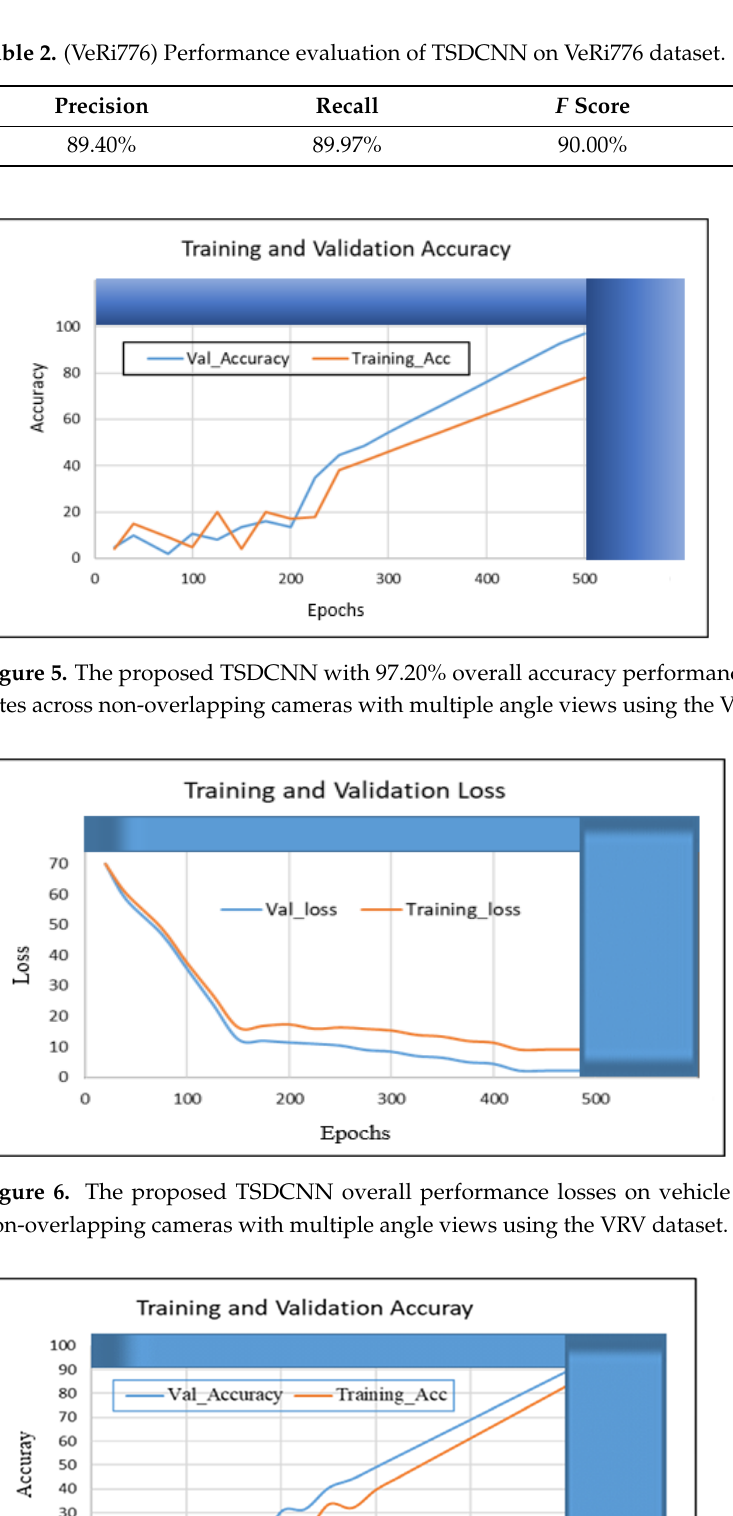
Table 1. Performance evaluation of TSDCNN on VRV dataset.